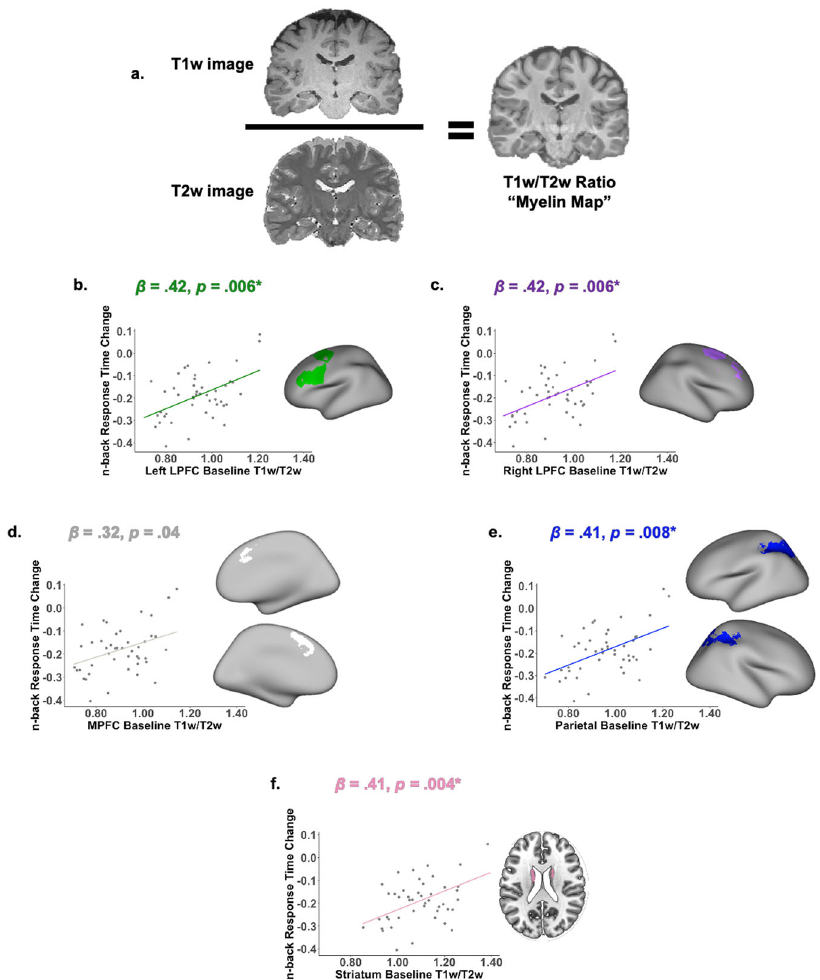
Fig. 4 Correlations between frontoparietal T1w/T2w signal intensity ratio and training-related changes in response time. a Schematic of T1 signal intensity divided by T2 signal intensity, as a proxy measure for myelination. b Task-based regions of interest ( b – f ) Positive relationships between baseline frontoparietal T1w/T2w signal intensity ratio and training-related changes in response times on the n -back working memory task. Axial slice is shown at z = 22. Statistical models control for age, sex, and baseline working memory response times. Asterisks denote p -values that survive